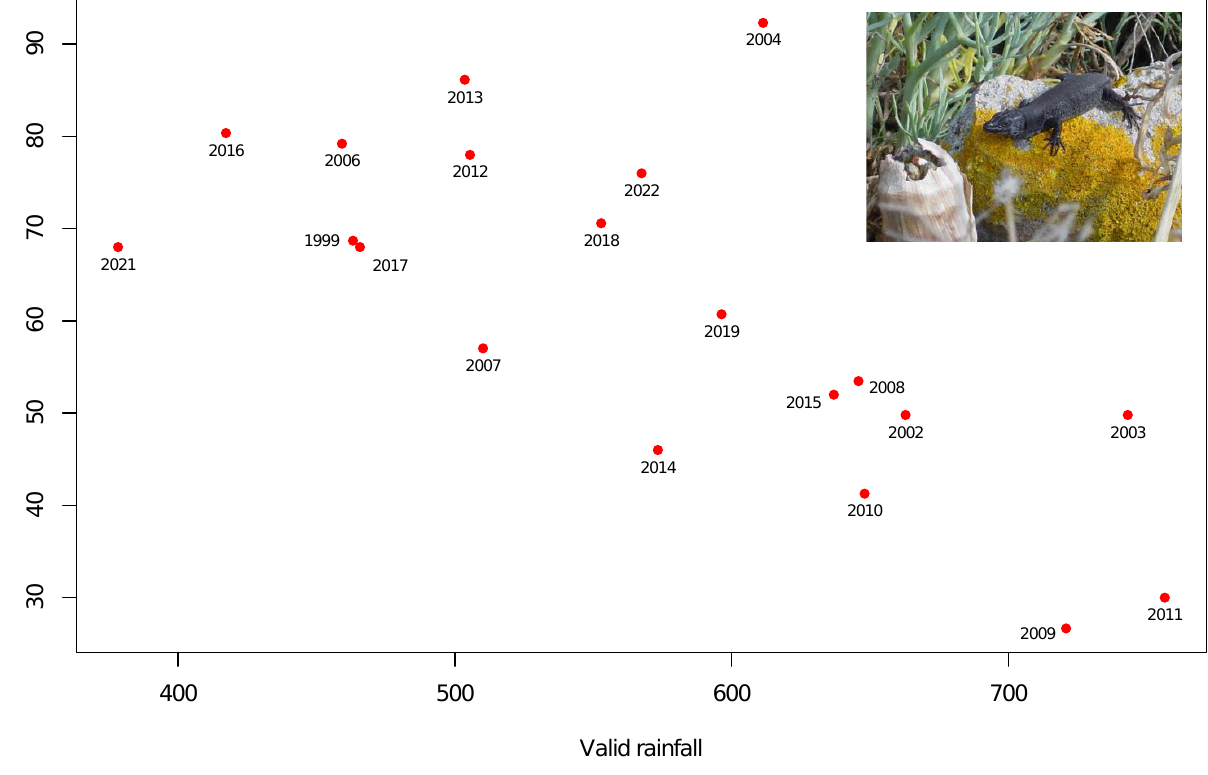
Figure 8. A negative correlation of dispersal intensity and valid rainfall at high-density area (H.D.) of Aire Island. In the upper right corner, an adult male of Podarcis lilfordi is looking at Helicodiceros muscivorus infrutescence, still with unripe fruits.